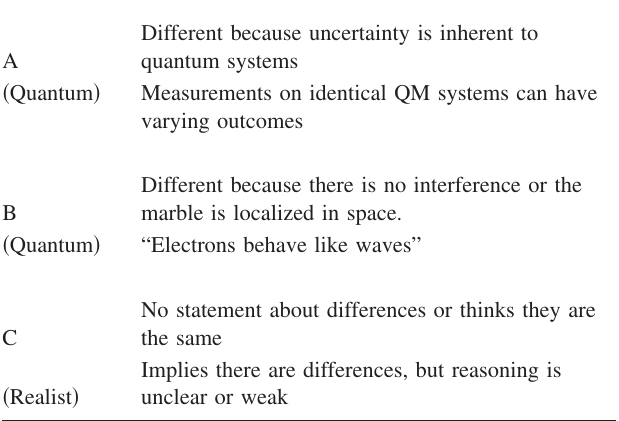
TABLE V. Categorization of responses to part II of the Plinko essay question.